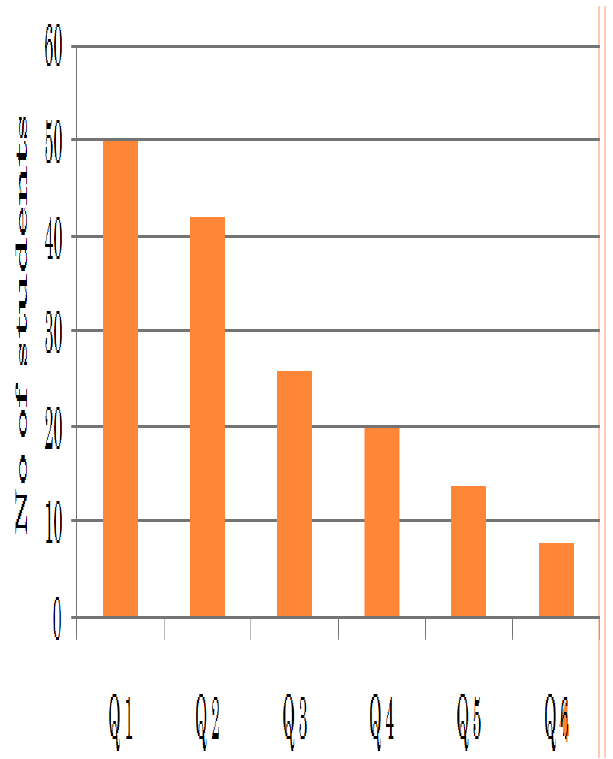
Figure 4. Results in graph The Figure 4. clarifies that the fifty understudies have taken a test which contains 6 inquiries as indicated by 6 levels of blossoming scientific classification, the bar